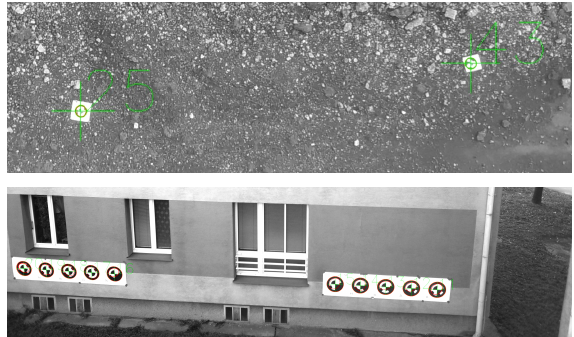
Figure 6: Automatically detected ground control points with plot- ted marker centers and corresponding marker